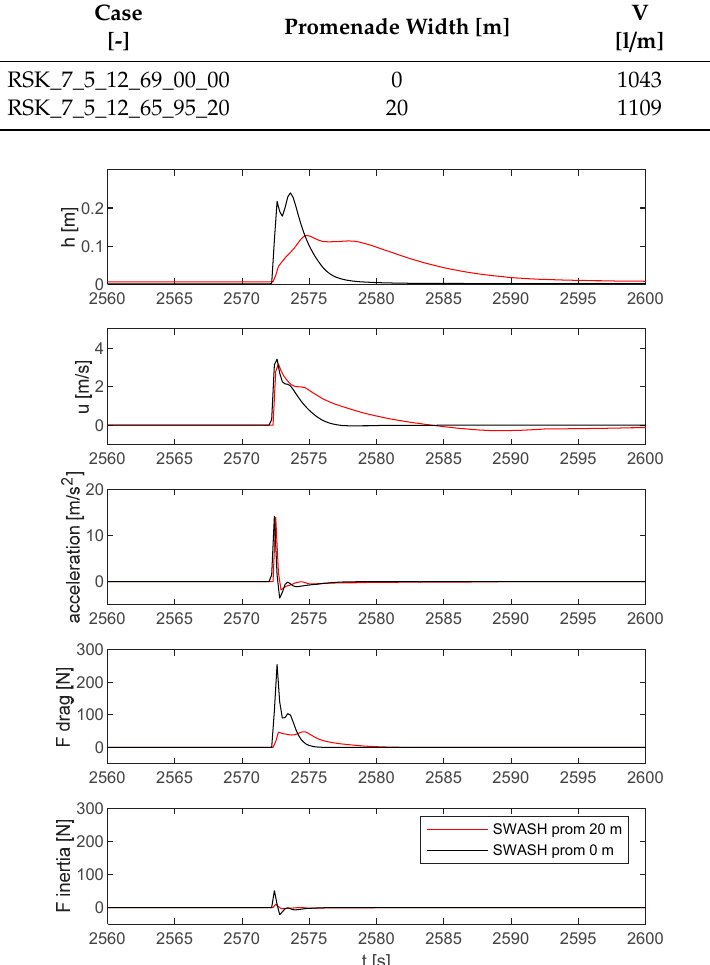
Figure 6. Time series of h, u, acceleration, F_drag and F_inertia for the case which V is around 1000 l/m (the red lines are slightly shifted to be able to compare with the black lines easily).